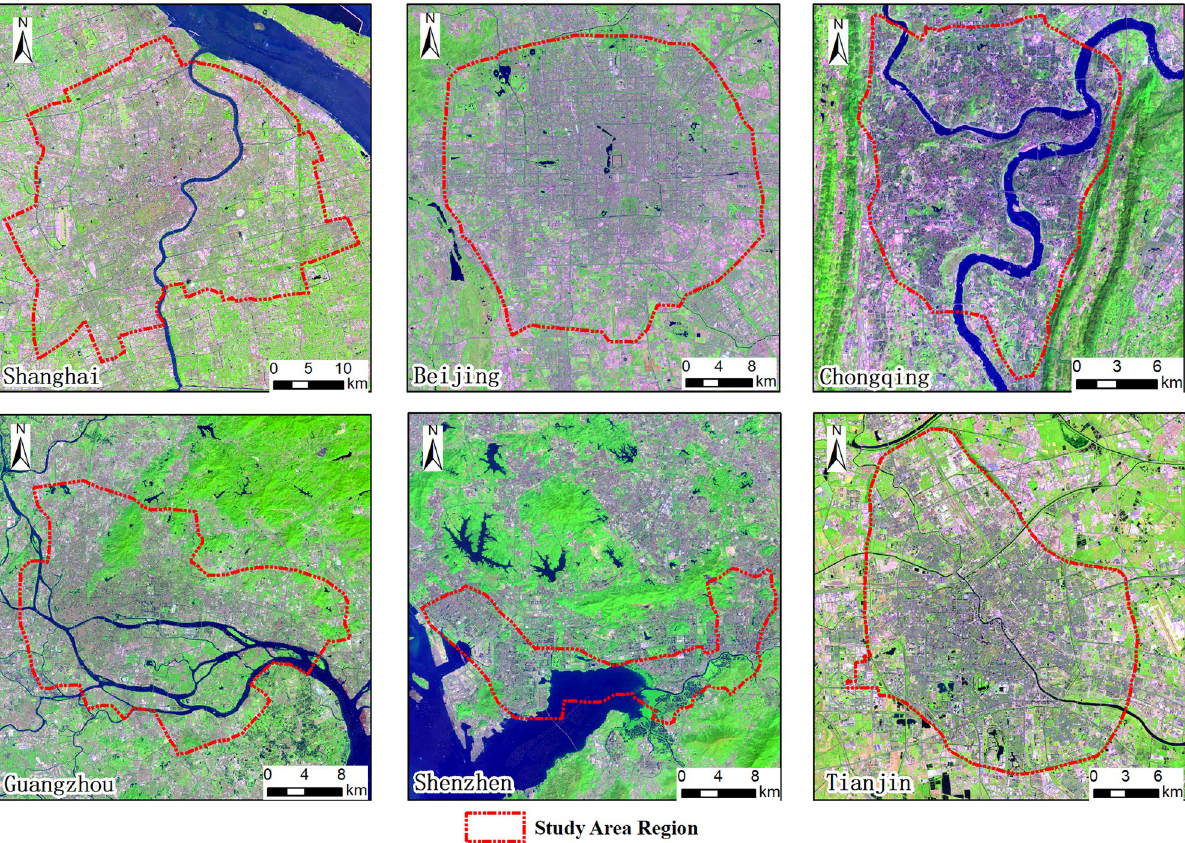
Fig 1. Landsat 8 OLI images of the six megacities (downloaded from USGS/NASA website).